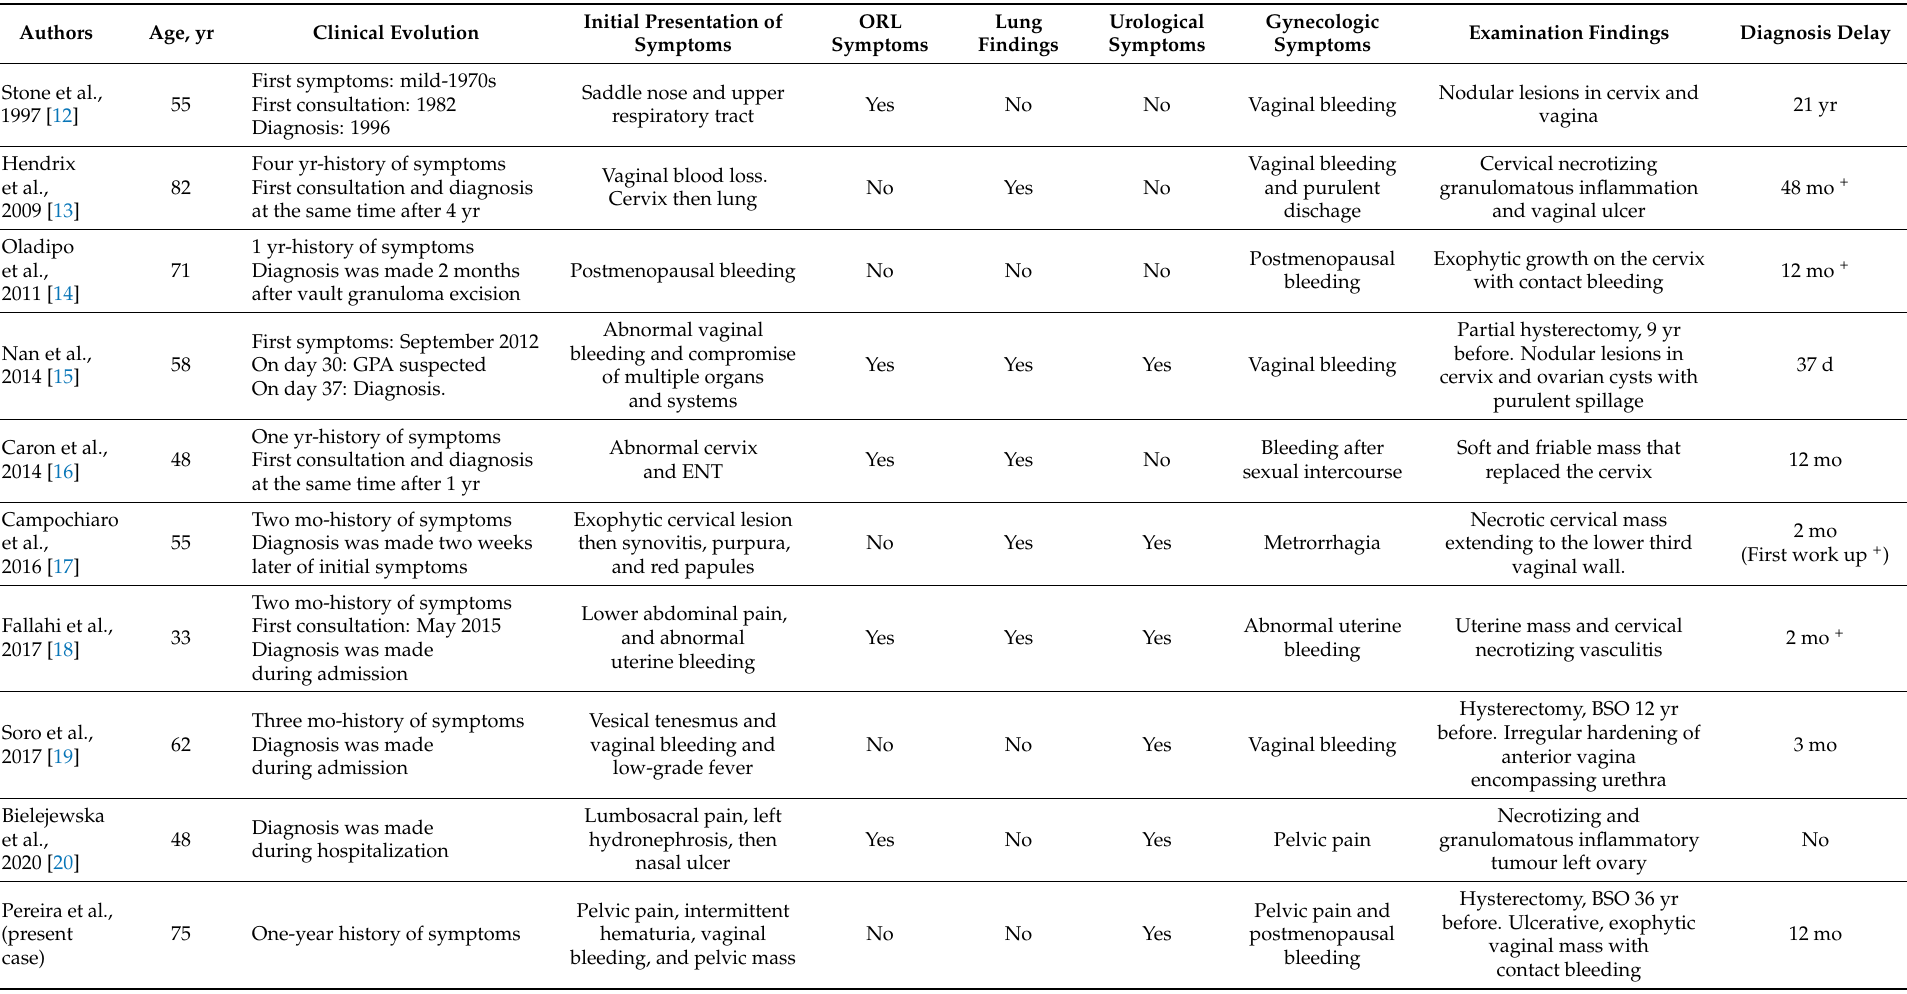
Table 1. Literature review of patients with GPA and primary gynecological